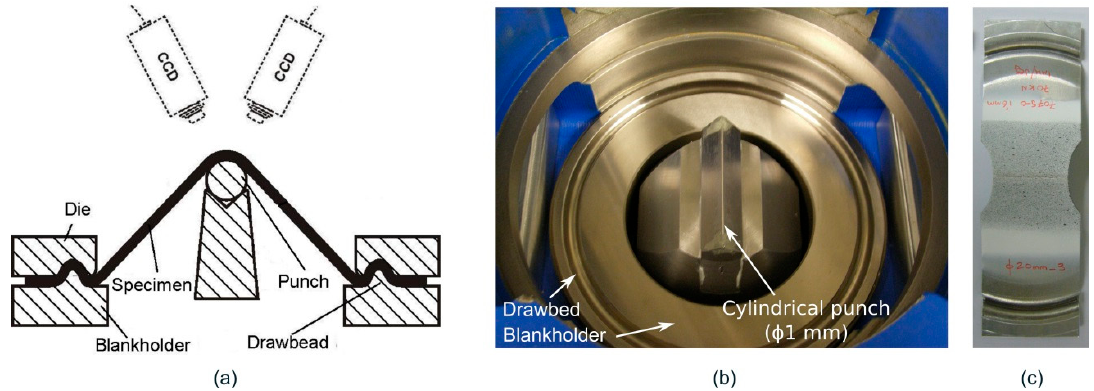
Figure 3. ( a ) Schematic and ( b ) experimental setup of stretch-bending tests; ( c ) geometry of the tested stretch-bend specimens.